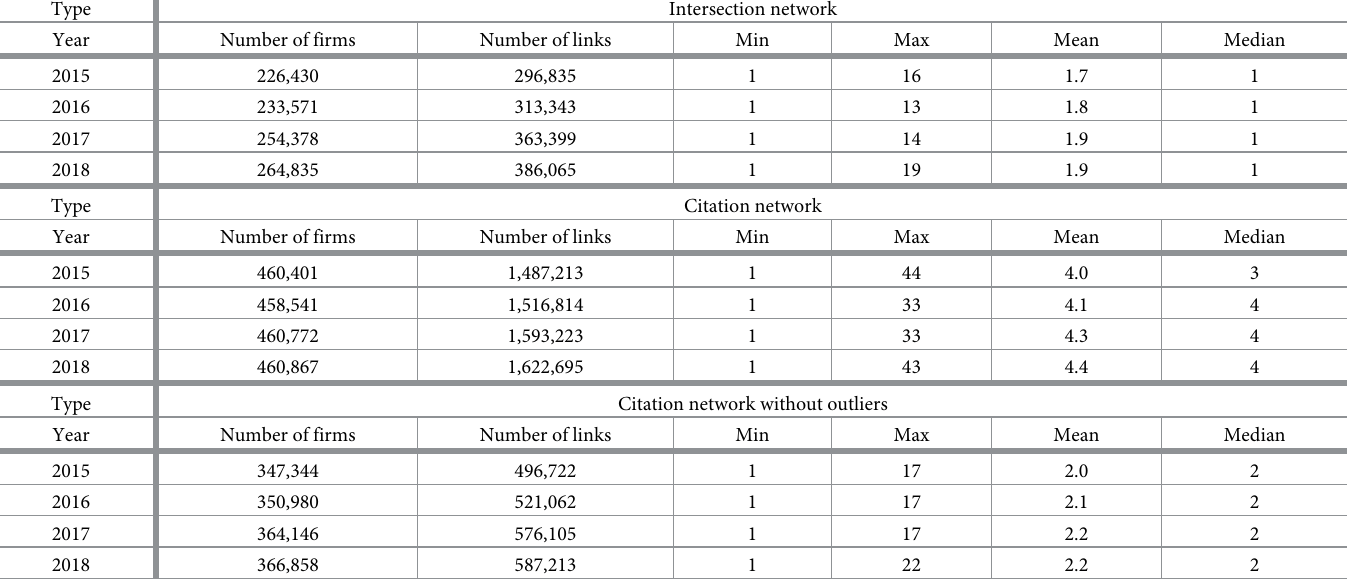
network as shown in panel (c). In the following discussion, we use the citation network with- out the outliers. Besides, Table 2 shows number of nodes and links in each type of network. This shows that 94,009 firms with 1,035,482 links on the citation network have been eliminated by this proce- dure in 2018. However, only 2% of all nodes on the intersection network have been eliminated corroborating the fact that almost all valid data is preserved. The elimination rate is also very consistent with the implied error rate arising from the manual procedure described in. Fur- thermore, in order to obtain additional comfort with regards to the effectiveness of the filtering method, we have manually sampled 1,000 firms within our dataset in the descending order of the respective differences between k and k . We found that links were correctly removed from b c 989 firms within the sample, and therefore, implying an error rate of around 1.1% which as Table 2. Details of each type of